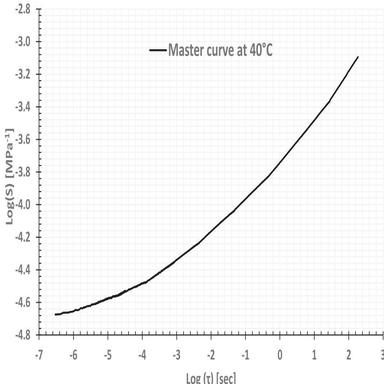
Creep compliance master curve at 40 °C obtained by shifting the individual short-term creep compliance shown in Fig. 4.